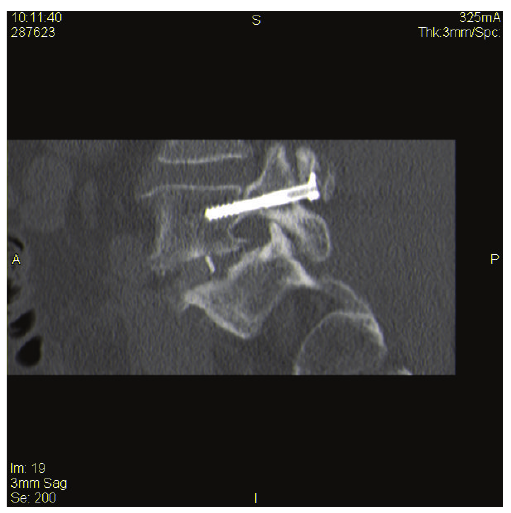
Figure 6: Bilateral lumbar fixation screws in the L5 vertebra.